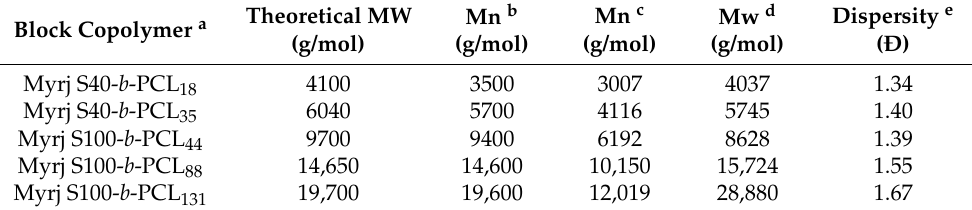
Table 1. Characteristics of the synthesized Myrj- b -PCL copolymers. Block Copolymer